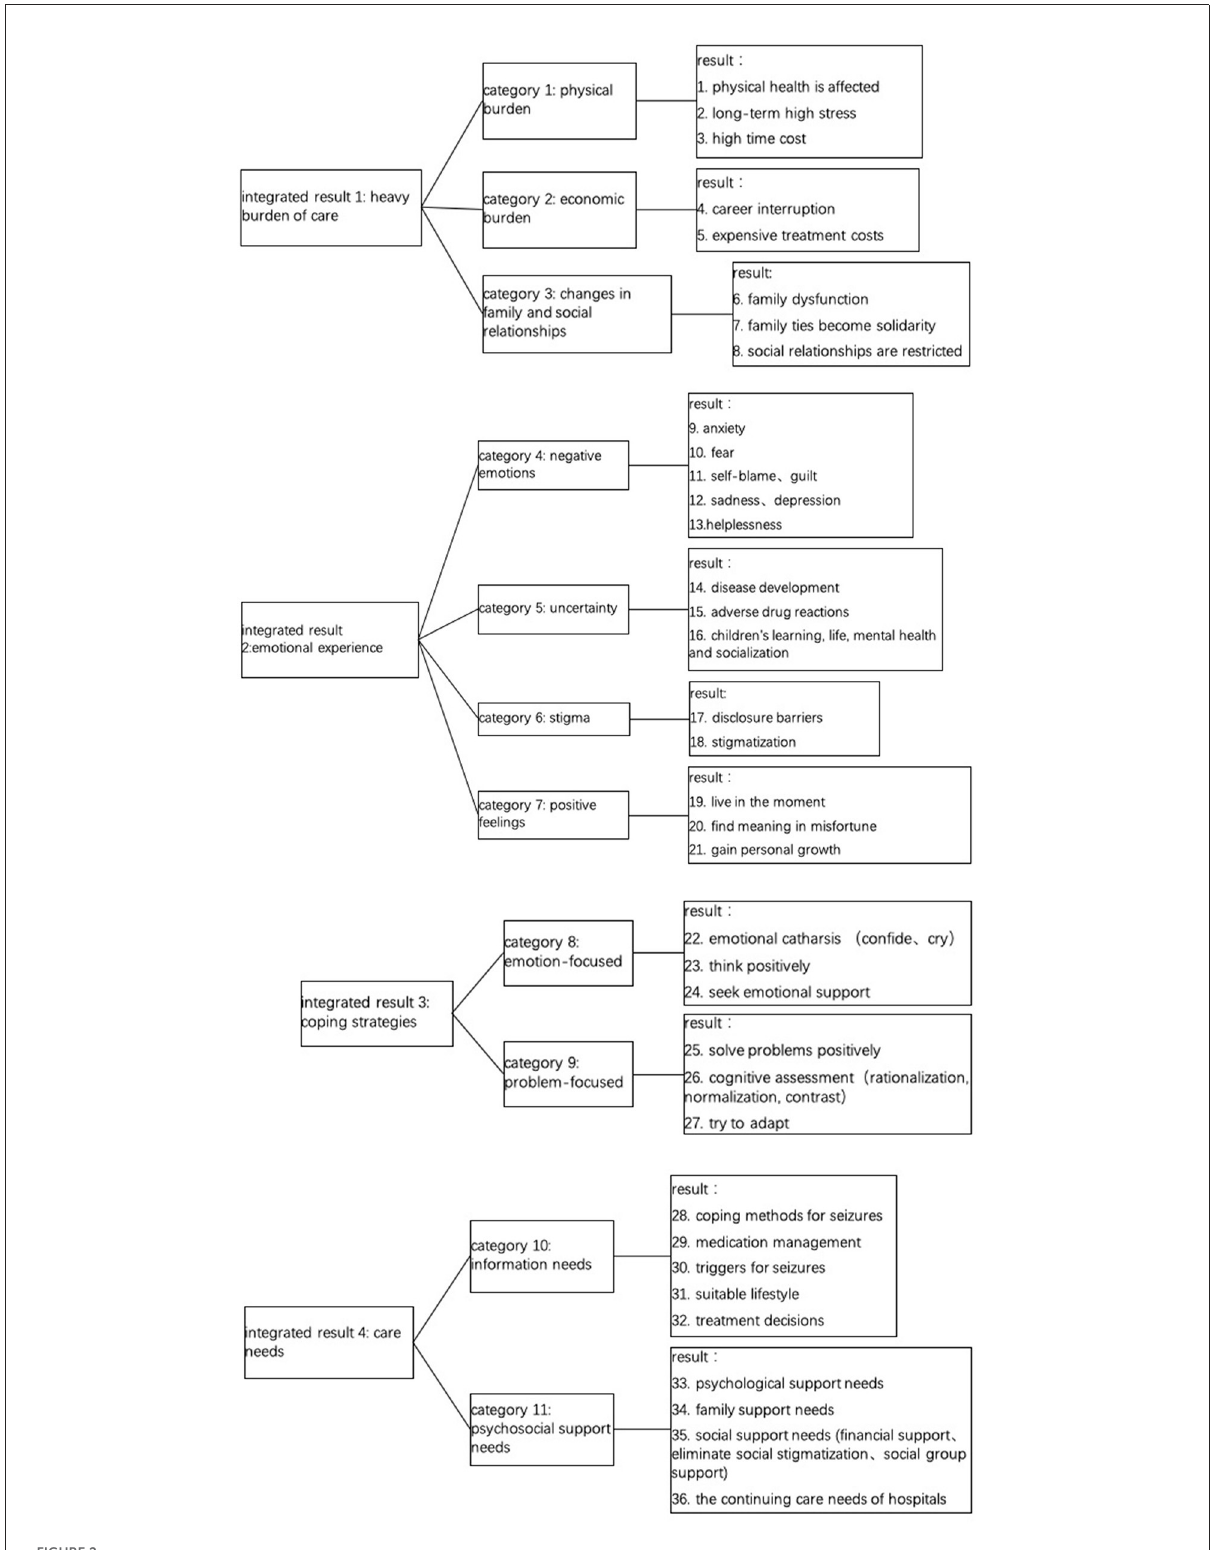
FIGURE2 Research results, categories and integrated results of included